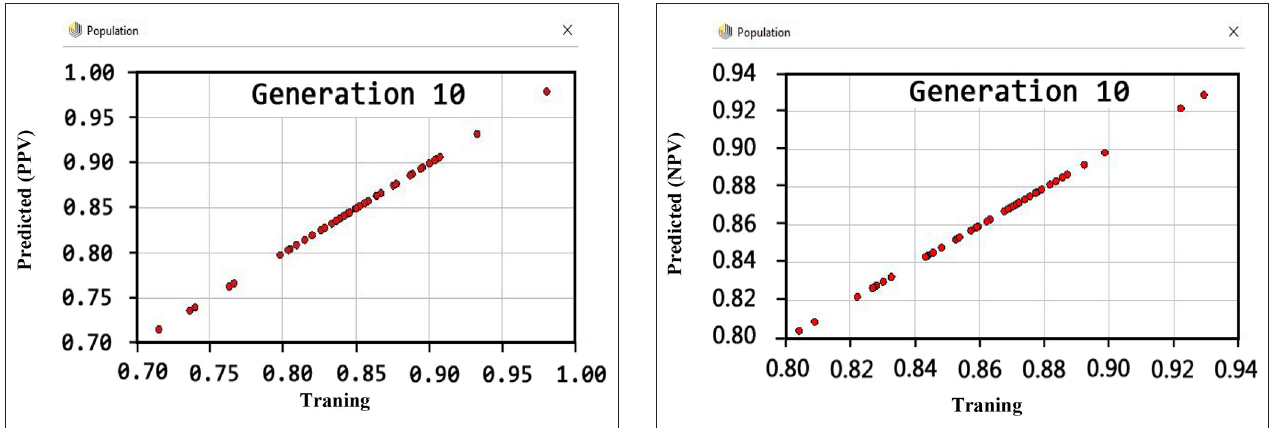
FIGURE 9 | NPV diagram for GSVNA method for generation 10.